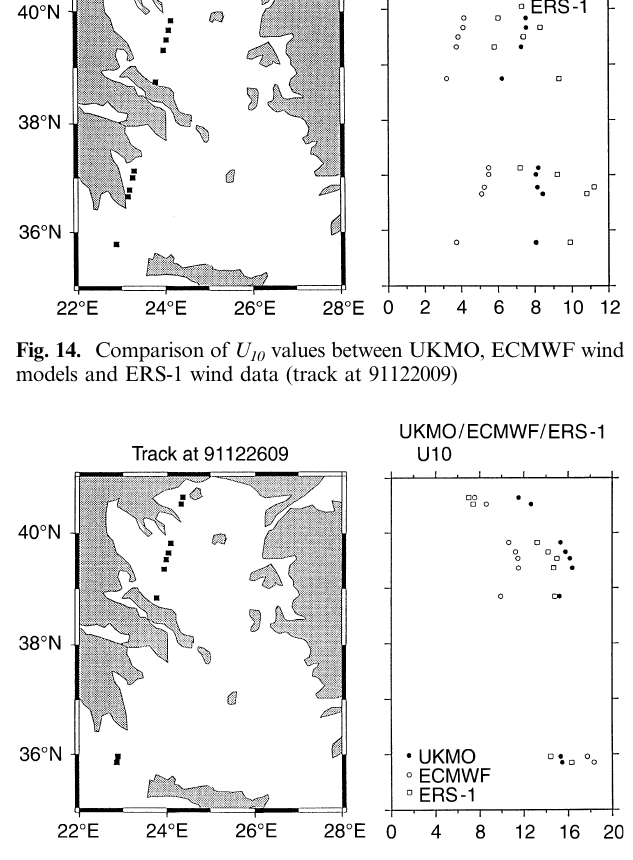
Fig. 15. Comparison of U 10 values between UKMO, ECMWF wind models and ERS-1 wind data (track at